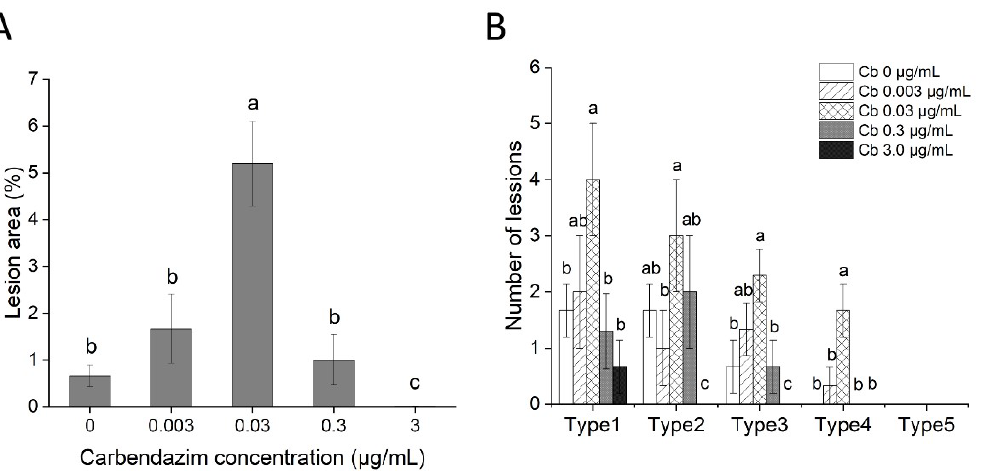
Figure 5. Quantification of lesion area ( A ), and lesion type ( B ), of Magnaporthe oryzae isolate Guy11 on detached rice leaves at 7 DPI. Error bars represent standard deviation, and different letters represent significant differences ( p <